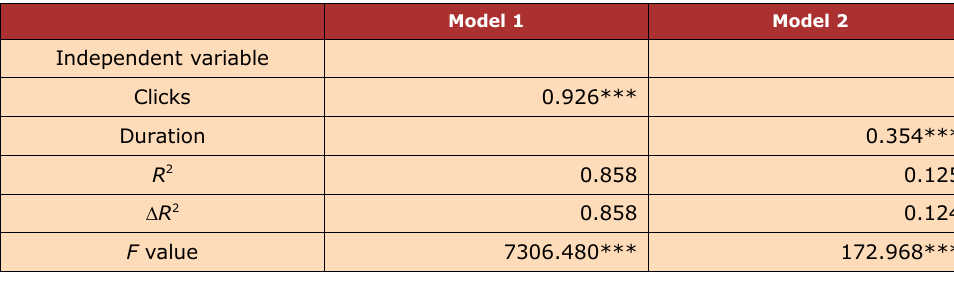
Table 7. Linear regression analysis of forum’s